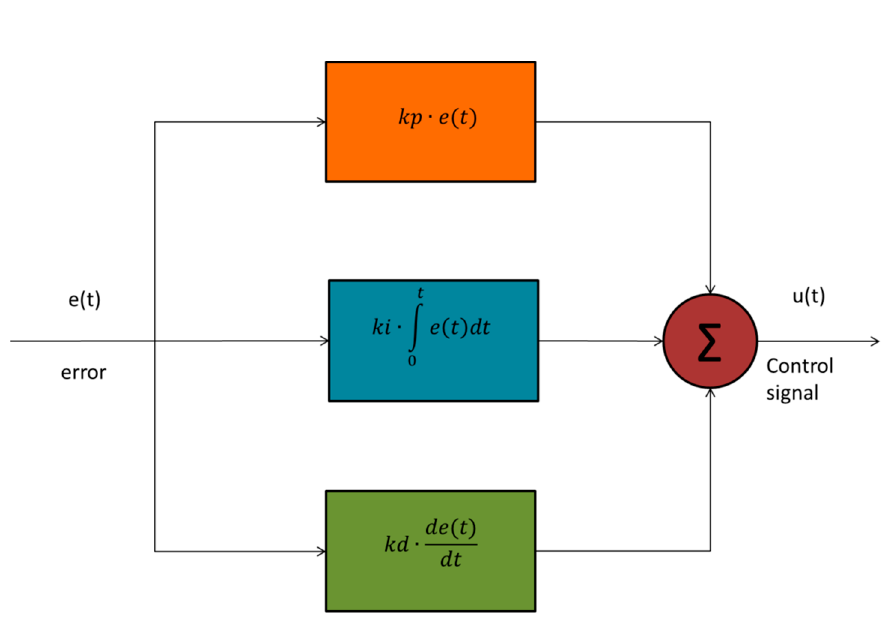
Figure 1. Block diagram of PID controller.